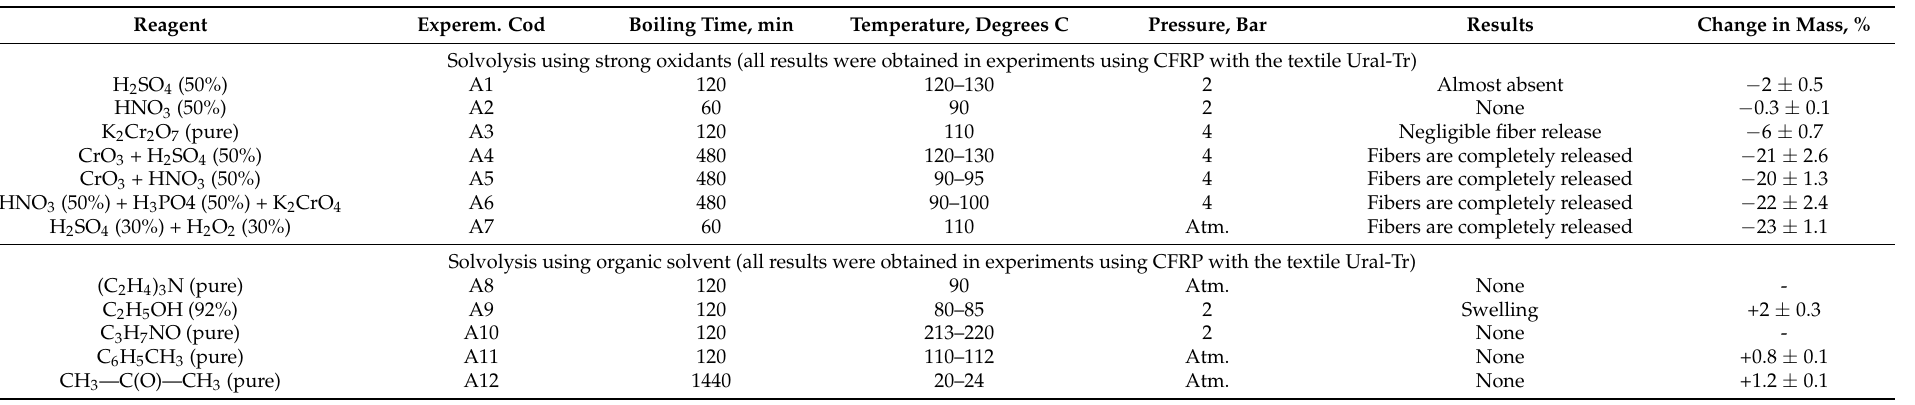
Table 2. Results of fiber extraction by solvolysis (Stage 1: Selection of optimal conditions of solvolysis).